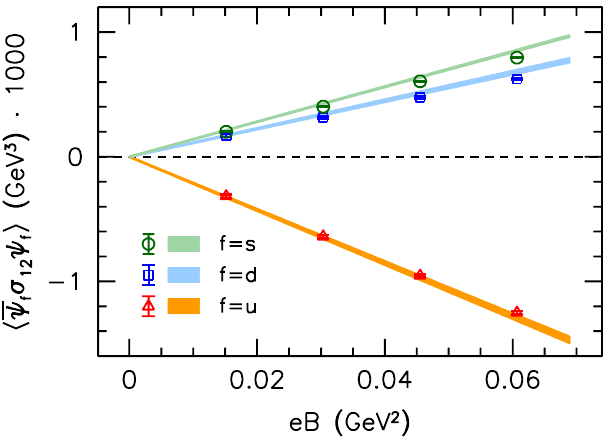
Figure 12 . Comparison of di(cid:11)erent methods to calculate (cid:28) fb for all three (cid:13)avors. Simulations at nonzero (quantized) values of the magnetic (cid:12)eld (points) are compared with a direct determination of the slope at B = 0 (colored